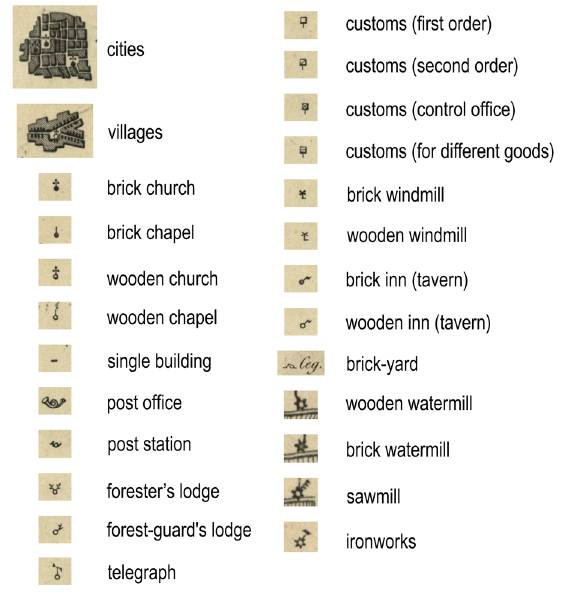
Fig. 4. A part of a legend of the Quartermaster’s